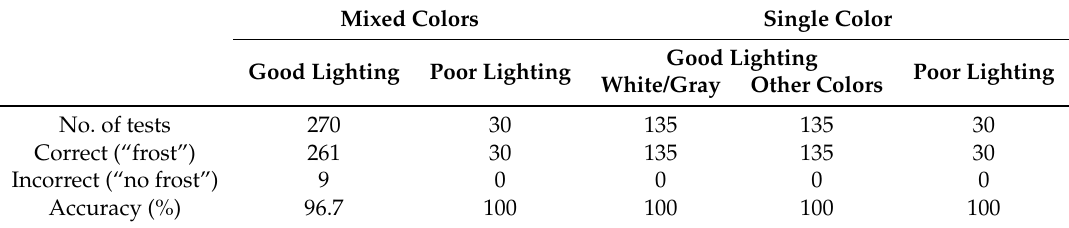
Table 5. False negative test results under the frost condition with the trained CNN and image brightness